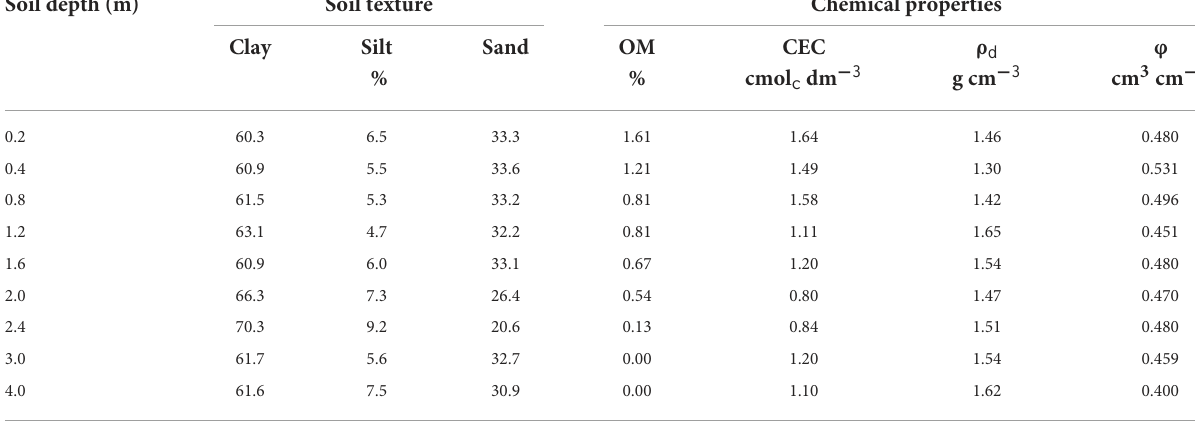
TABLE 1 Physical and physic-chemical soil properties along the upper 4 m of the soil profile. Soil depth (m) Soil texture